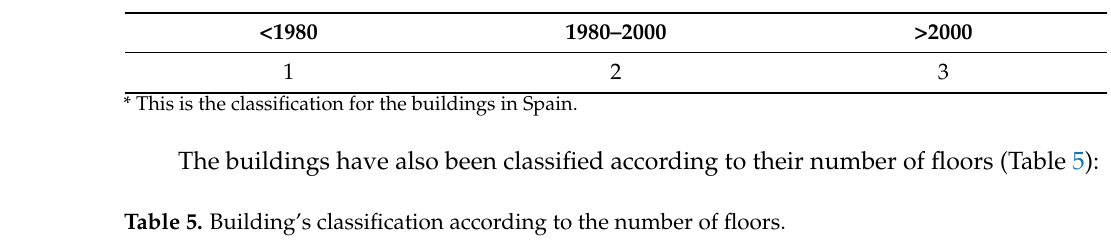
Table 4. Building’s classification according to the year of construction *.